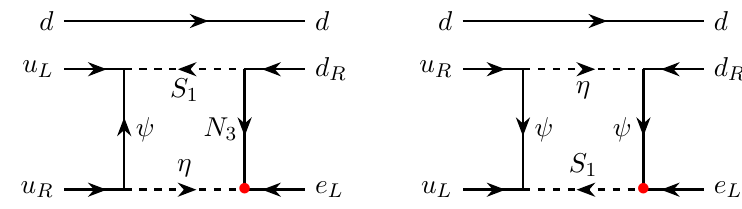
Figure 4 . The Feynman diagrams of proton decay. Our model assumes the red vertex to be zero to forbid proton decay.